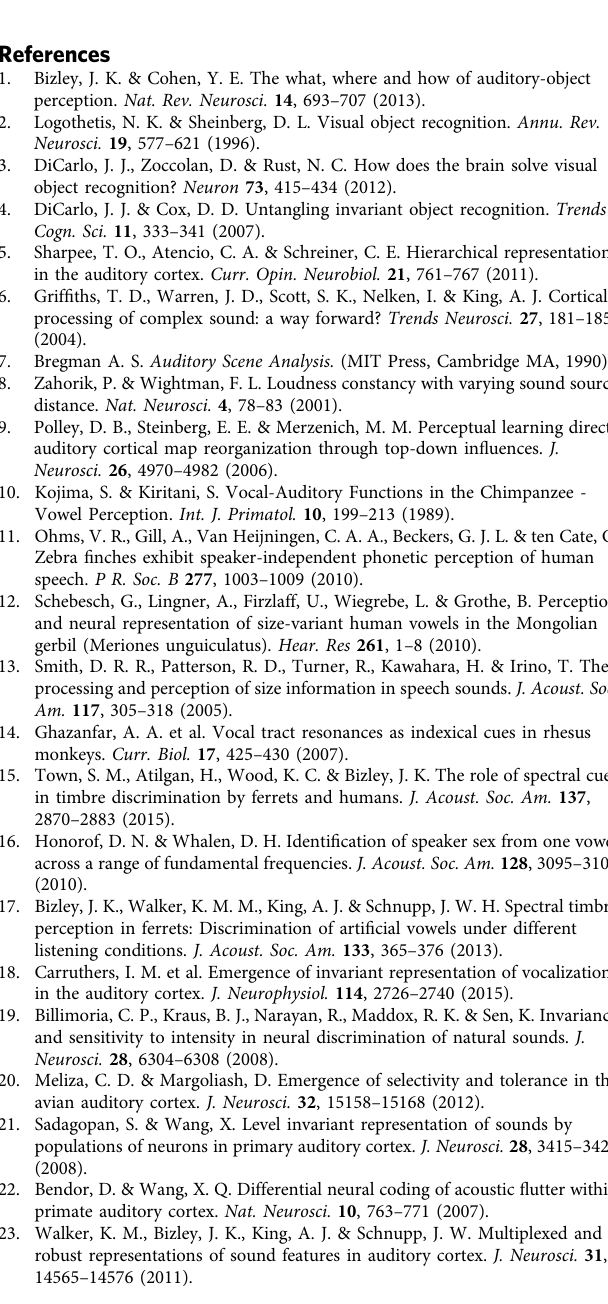
Data availability The datasets generated during and/or analyzed in the current study are available from the corresponding authors on reasonable request. Data presented in all fi gures are available from fi gshare with the identi fi er 10.6084/m9. fi gshare.7176470 [https:// doi.org/10.6084/m9. fi